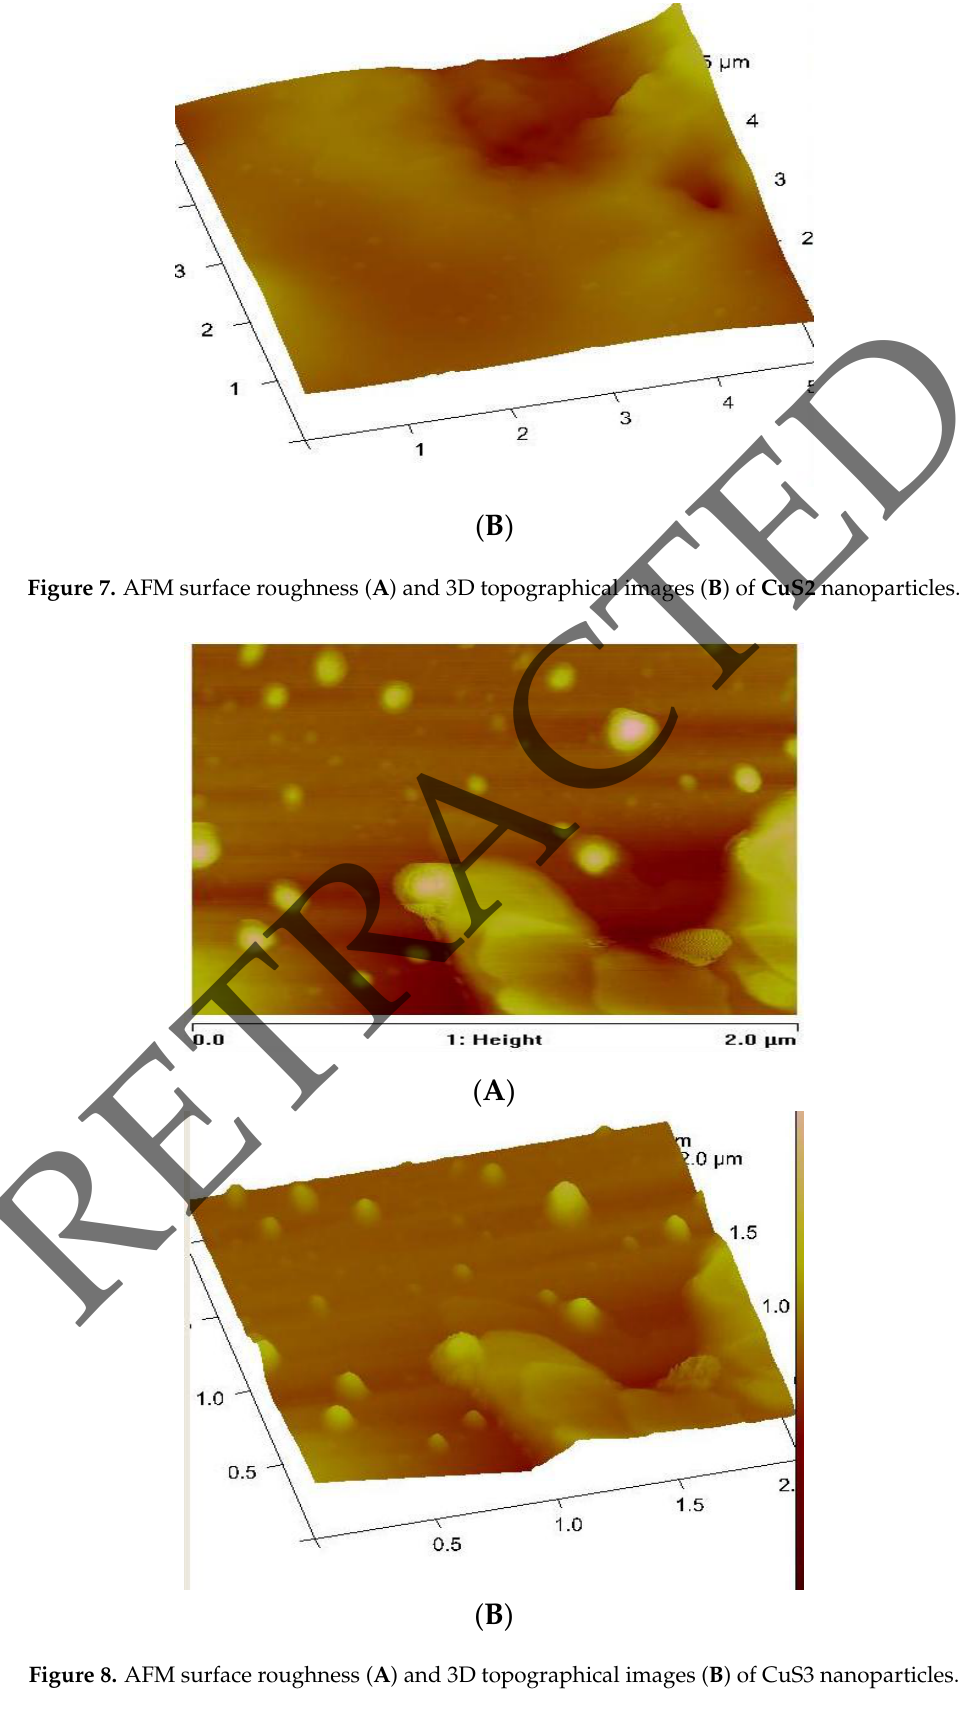
Figure 8. AFM surface roughness ( A ) and 3D topographical images ( B ) of CuS3 nanoparticles.